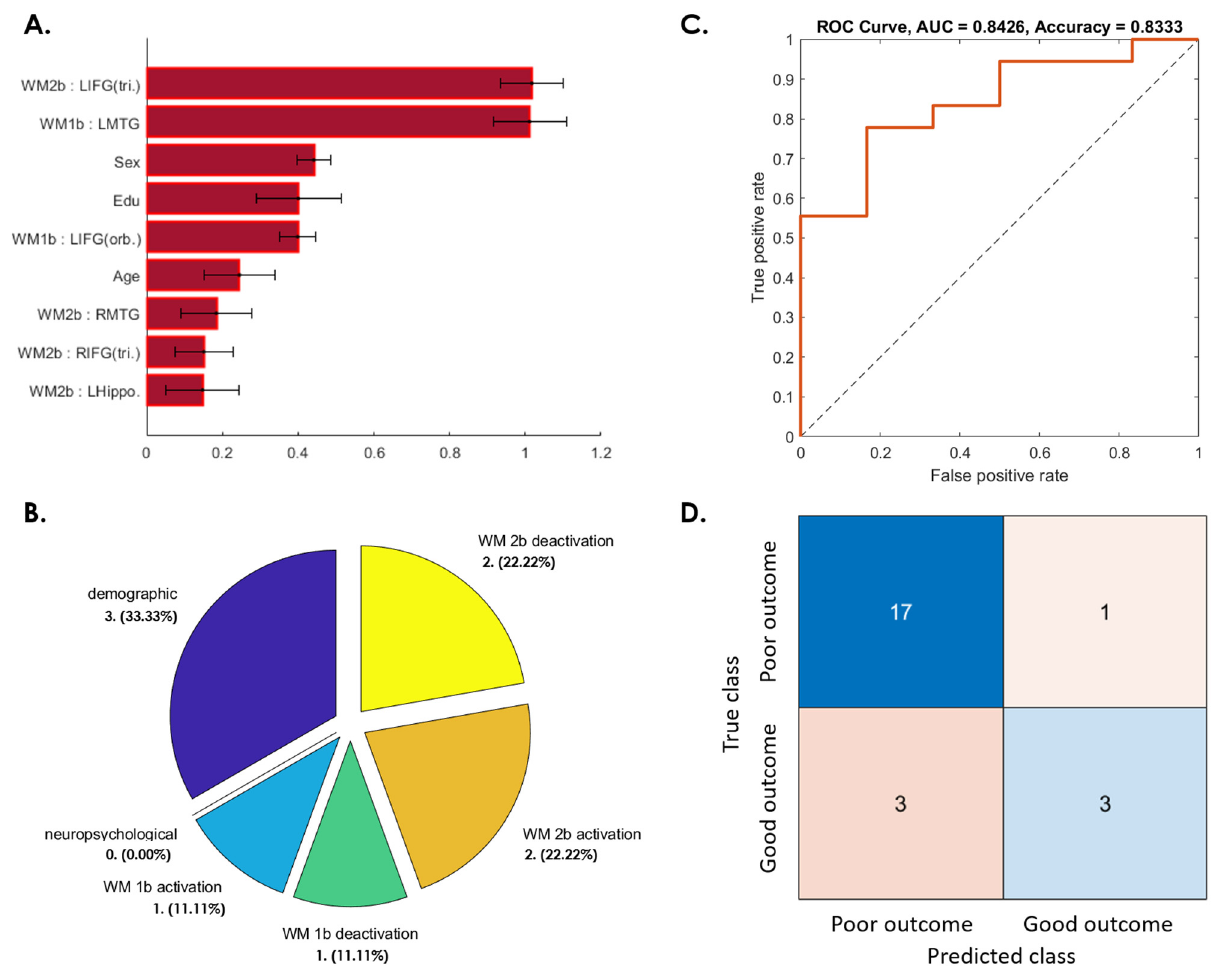
Figure 4. SVM predictive model for 75% of patients whose WM ability dropped from 3 to 6 months after a concussion. ( A ) The red bar graph and the corresponding error bar, respectively, represent the average and standard deviation of the discriminative feature weights among the 10 cross-validated SVM classifiers. ( B ) Profiles of the selected features for constructing the SVM classification model. None of the neuropsychological features were selected for this predictive model. ( C ) ROC curve of the selected feature to discriminate the “poor outcome group” from the “good outcome group”. ( D ) Confusion matrix to summarize the results of this binary classification